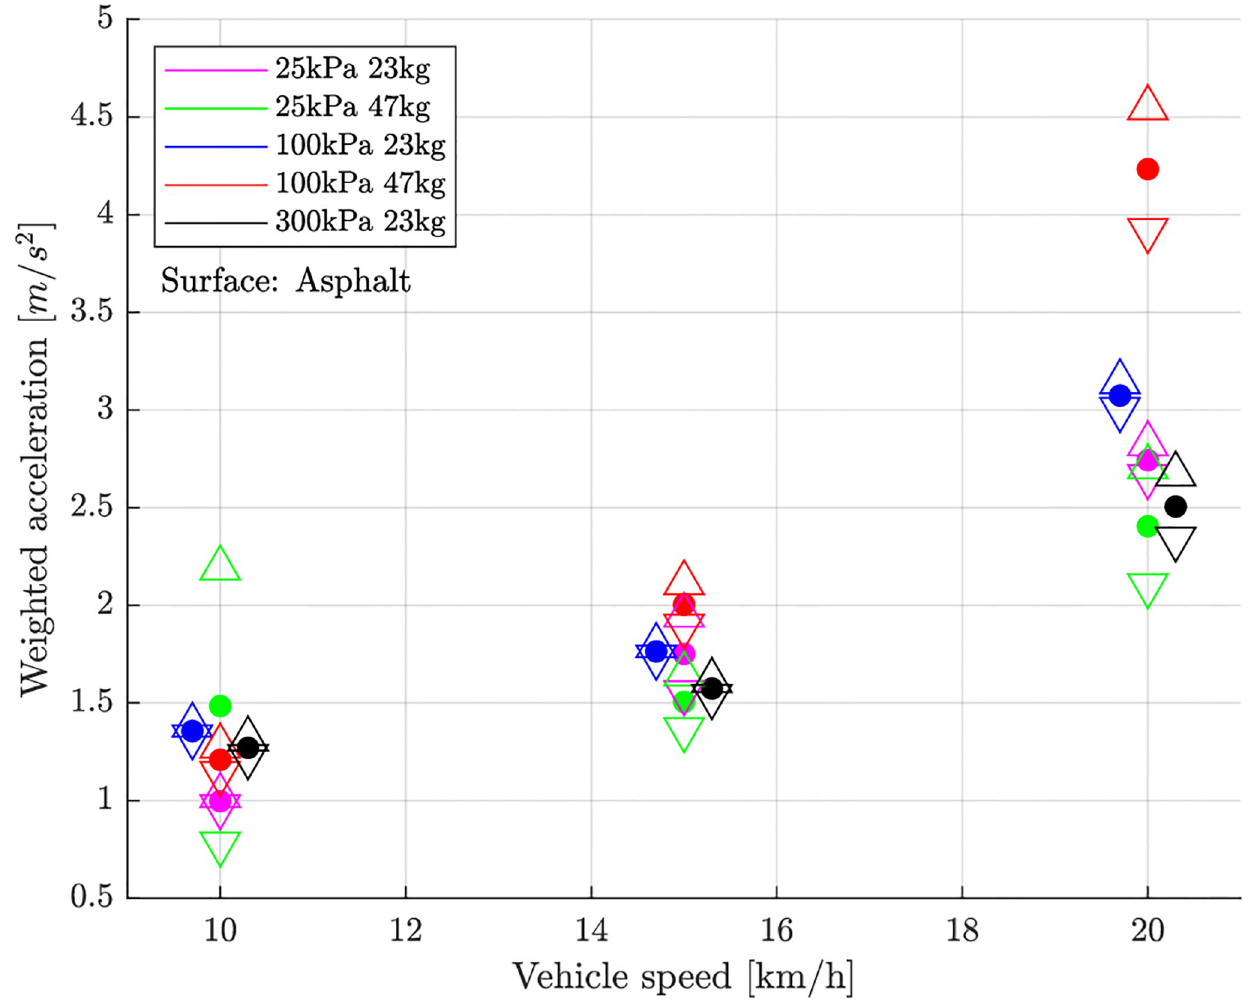
Fig 4. Child carrier: Weighted vibration level over vehicle speed on fine asphalt surface. 4 and 5 indicate the 95% confidence interval. Black and blue values have been moved laterally by a few mm for better